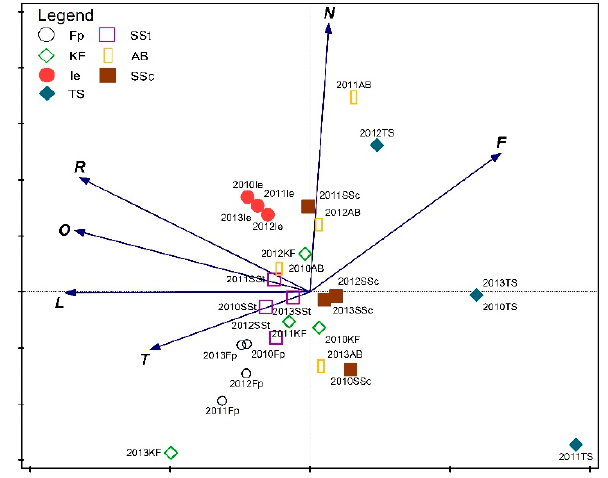
Figure 4. Characteristics of the studied plant associations in the years 2010–2013 with PCA analysis using Ellenberg indicator values of fungi. Legend: AB— Adonido – Brachypodietum pinnati , Fp— Festucetum pallentis , Ie— Innuletum ensifoliae , KF— Koelerio – Festucetum , SSc— Seslerio – Scorzoneretum purpureae , SSt— Sissymbrio – Stipetum capillatae , TS— Thalictro – Salvietum pratensis ; indicators: L—light